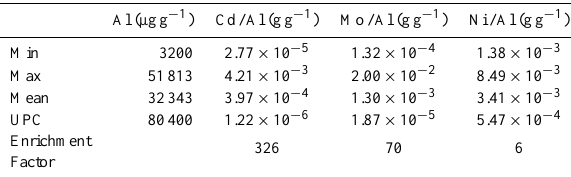
Table 2. Minimal, maximal, and mean values for Al content (µgg − 1 ), Cd/Al, Mo/Al, and Ni/Al in MD08 core. Mean val- ues in Upper Continental Crust (McLennan, 2001) and mean en- richment factors ((Mean Element/Al) MD08 /(Element/Al) UPC ) are displayed at the bottom of the